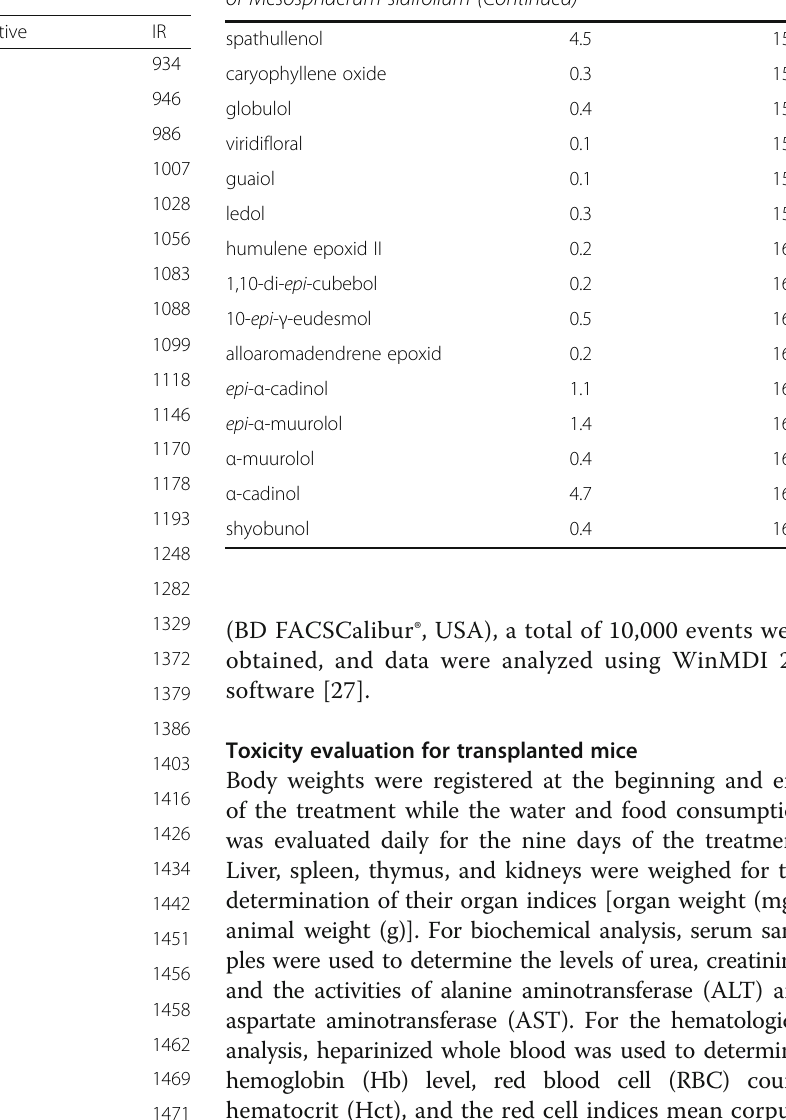
Table 1 Chemical composition of essential oil from aerial parts of Mesosphaerum sidifolium